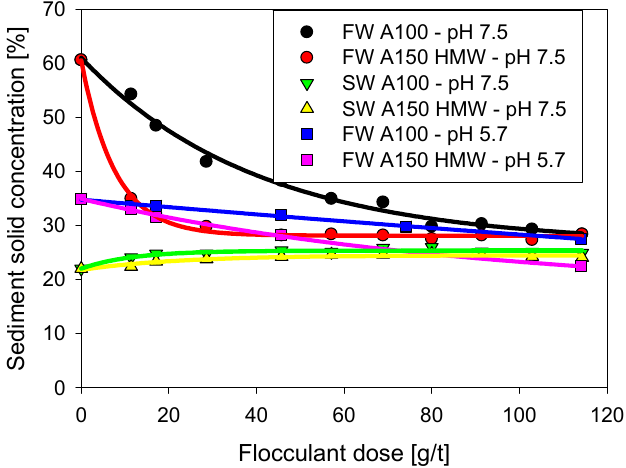
Figure 8. Solid concentration (wt. %) kaolin sediments generated by settling of flocculated slurries with A150 HMW or A100 in three conditions: (i) Distilled water (NaCl 0.01 M) at pH 7.5, (ii) seawater at pH 7.5, and (iii) distilled water (NaCl 0.01 M) at pH 5.7. Flocculation time: 2.5 h.